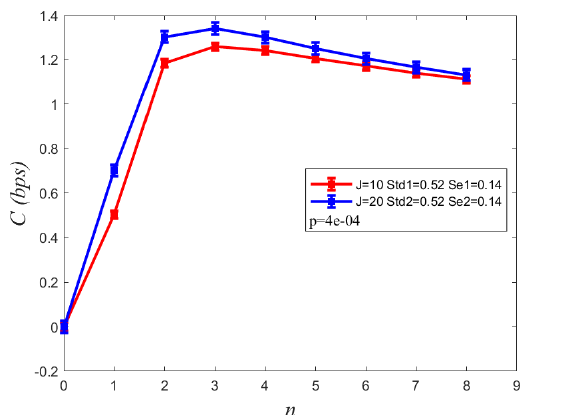
Figure 5. Comparison channel capacity C with the symbol duration T b between two symbols, T b = n ∗ t p , n = 1, ..., 8. J denotes the photolysis reaction coefficient. Std and Se denote standard deviations and standard error, respectively.